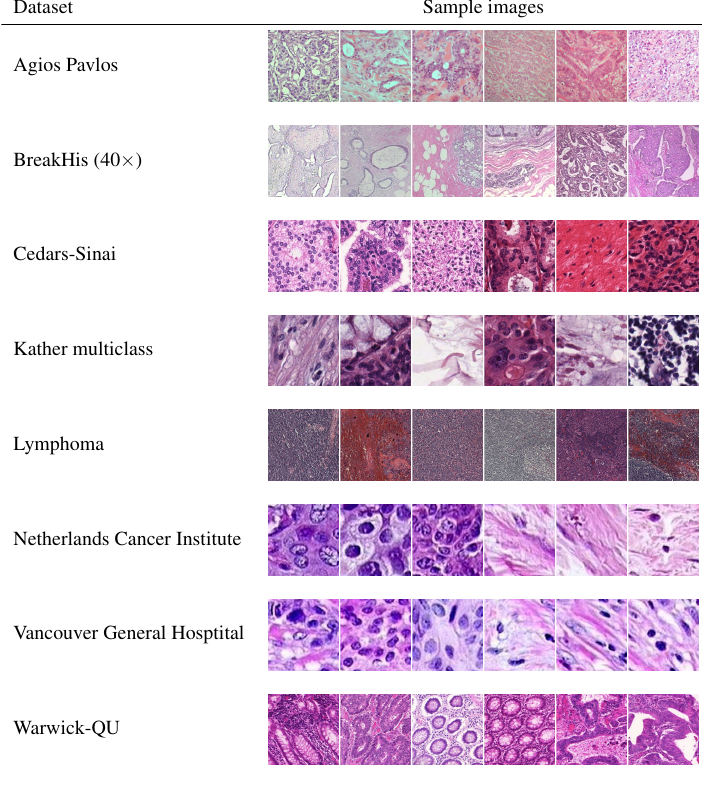
Figure 1. Six representative sample images from the datasets used in the experiments. It should be noticed the diverse gamut of colors as well as the different magnifications, density and cell density of the datasets. Cedars-Sinai by courtesy of Cedars-Sinai Medical Center ( c (cid:13) 2020 Cedars-Sinai Medical Center. All rights